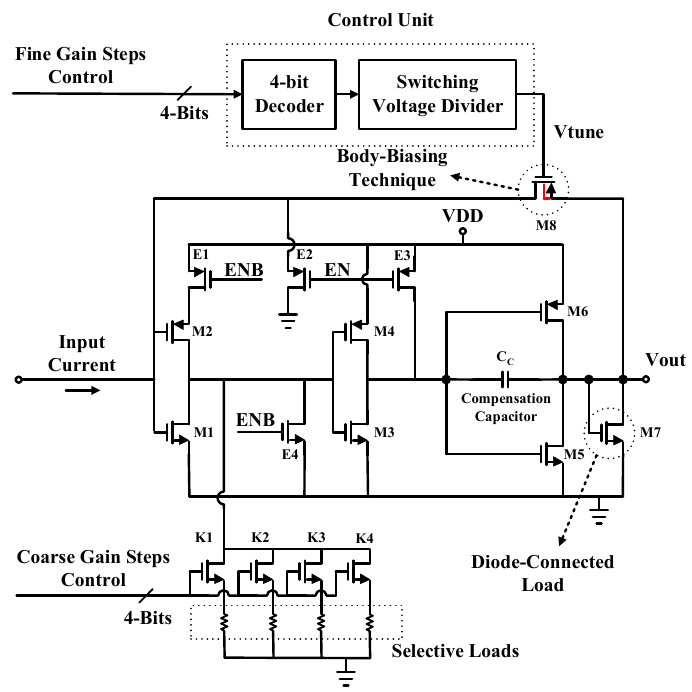
Figure 2. The proposed dual-gain-mode TIA.